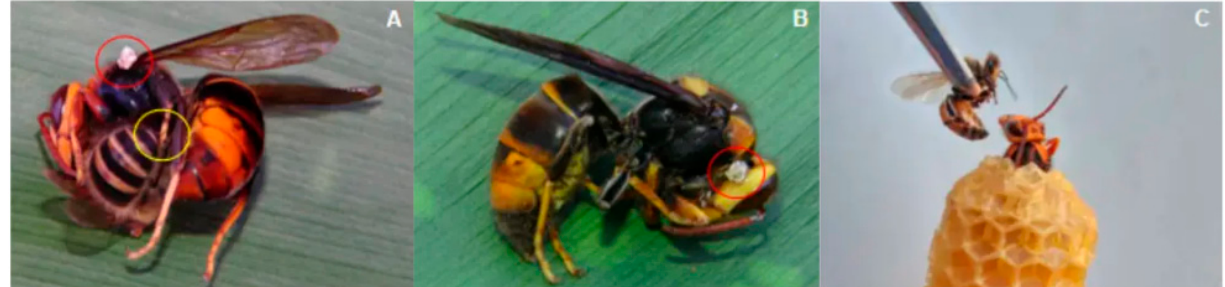
Figure 1. ( A ) An A. cerana guard attempting to sting (yellow circle) a V. velutina worker that has already been naturally